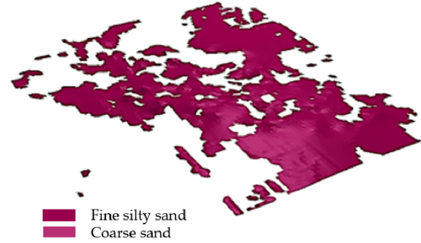
Figure 16. The final geological model of the old town in Xinyang City with five perspectives. 7. Discussion and Conclusions This paper mainly introduces intelligent preprocessing of papery borehole data, automatic extraction and standardization of borehole information, and a certain degree of editing and adjustment of the profiles. The whole process improves the shortcomings of data loss, data confusion and data distortion in the traditional geological model processing, makes the creation of the whole 3D geological model more intelligent and automatic, reduces the mistakes caused by manual